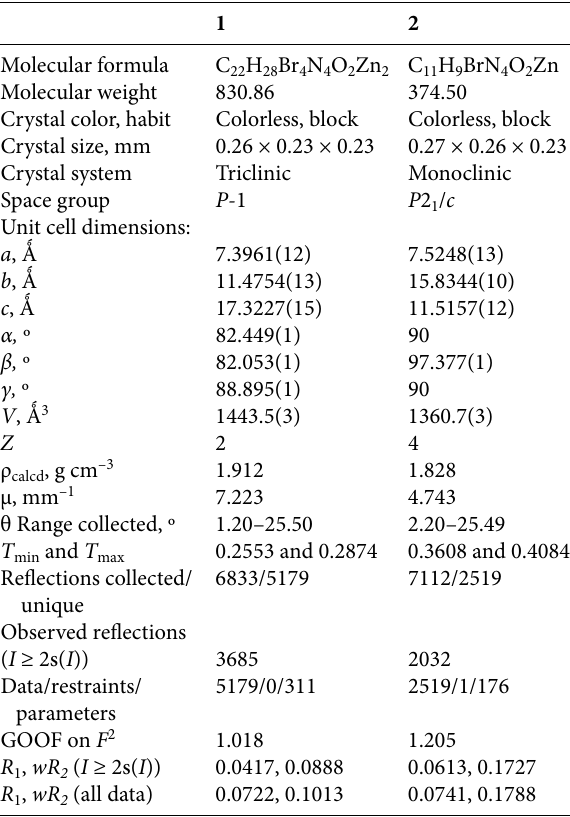
Table 1b. Crystallographic data and refinement details for the co- balt